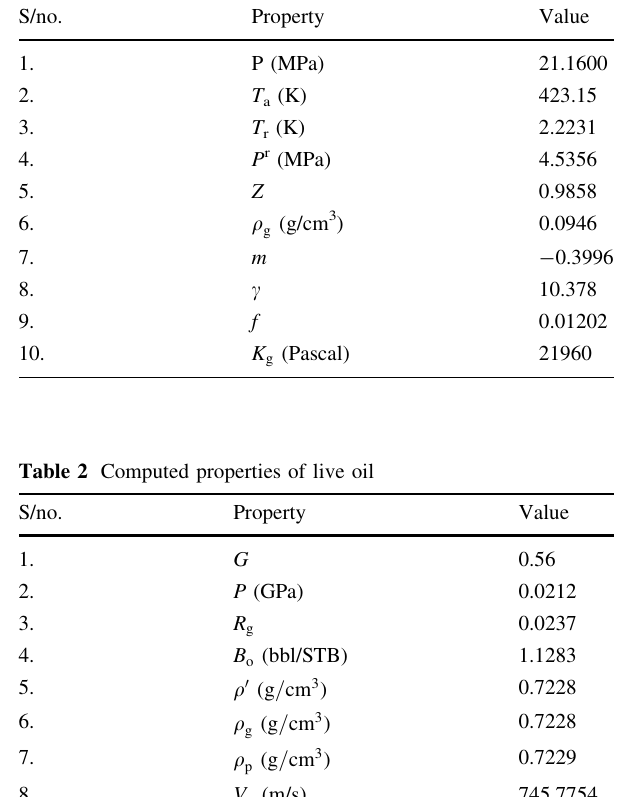
Table 6 Computed parameters of reservoir fully saturated with brine